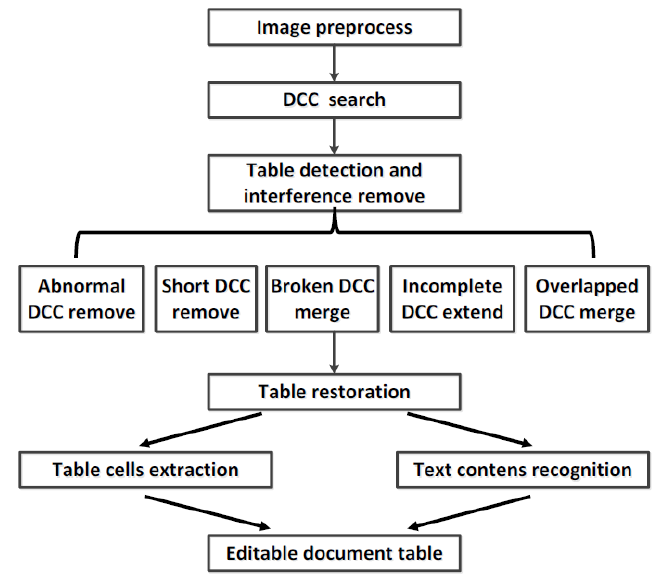
Figure 2. Table-recognition process. DCC: Directional Connected Chain.